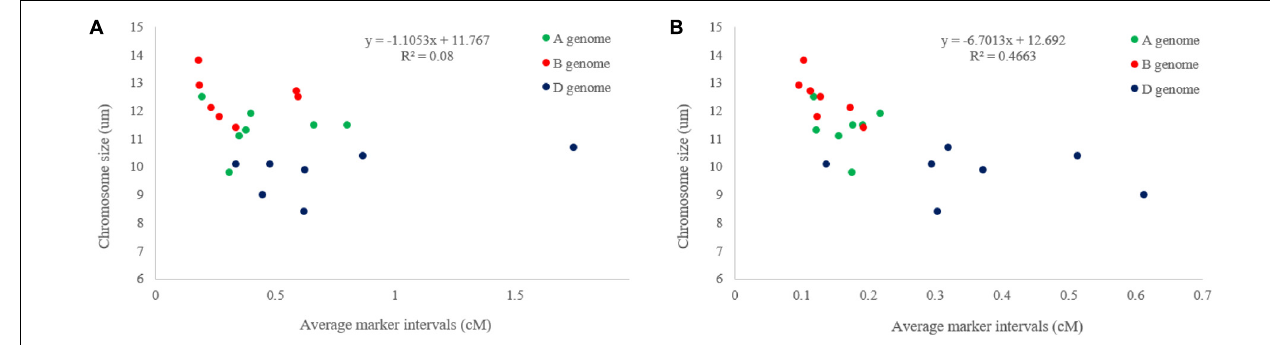
FIGURE 3 | Correlation of average marker intervals (cM) per chromosomes with physical chromosome size estimated by (A) CSSS and (B) W7984 assemblies.